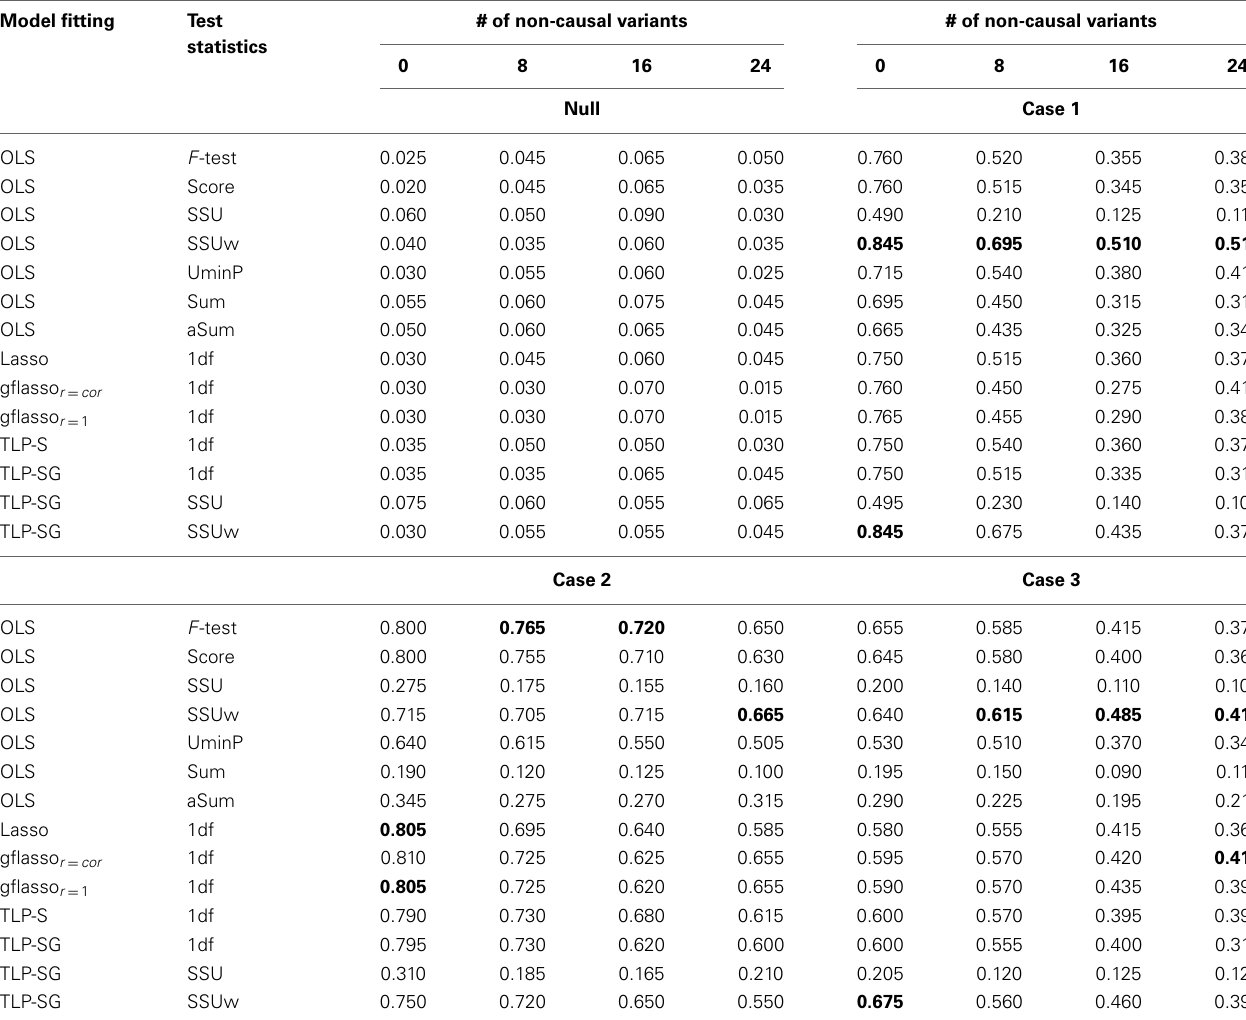
Table 2 | Empirical Type I error and Power at the nominal level α = 0 . 05 based on 200 replicates for the RVs + CVs set-ups with six causal variants and a varying number of non-causal ones.